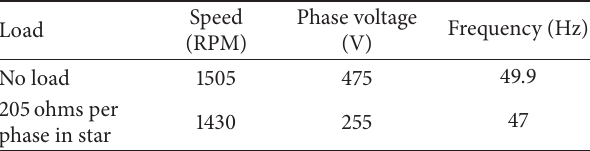
measured in rpm. The hardware experimental setup figures whenever the load changes due to the consumer loads.